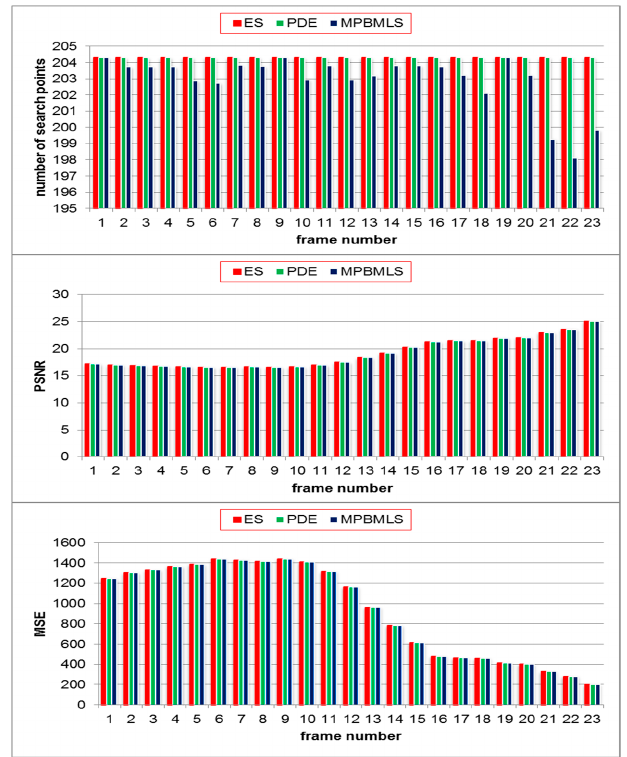
Figure 8. Average number of search points per MB, PSNR performance, and MSE of MPBMLS, FS, and PDE in the “Stefan” video sequence over 23 frames.